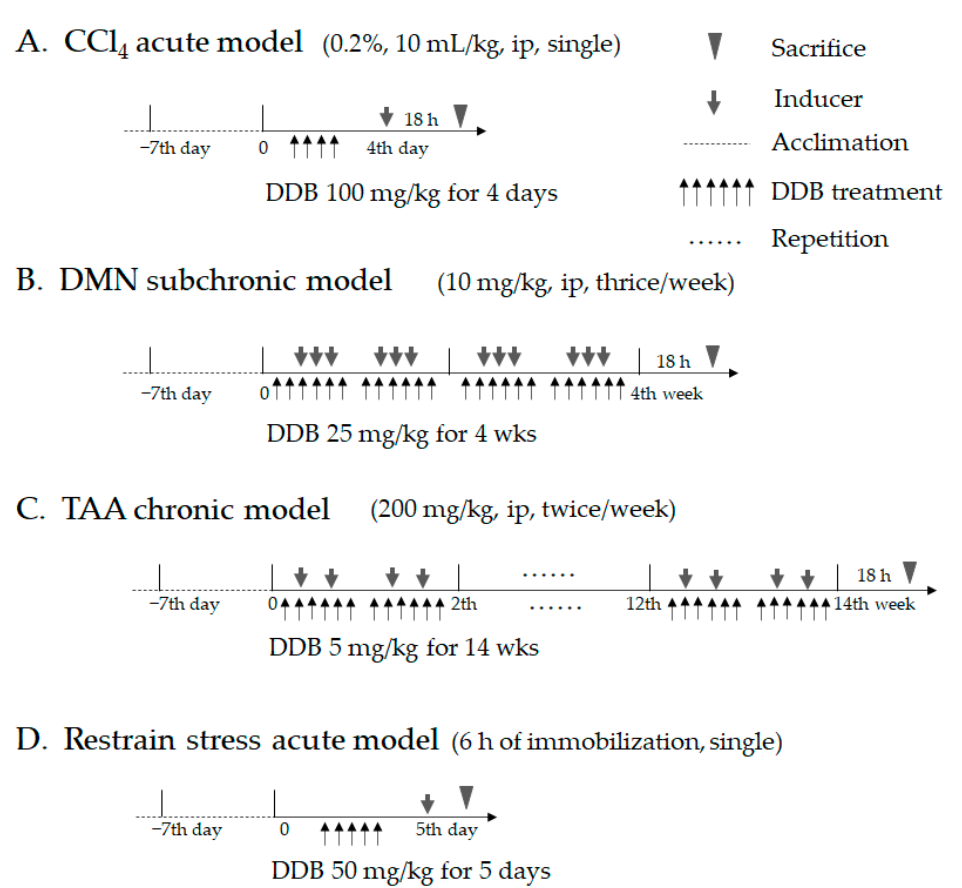
Figure 1. Experimental schedule of the four liver injury models. The experimental schedule scheme regarding the CCl 4 acute model ( A ), DMN subchronic model ( B ), TAA chronic model ( C ), and restraint stress model ( D ) are illustrated in detail. Table 1. Experimental design of four liver injury animal models.